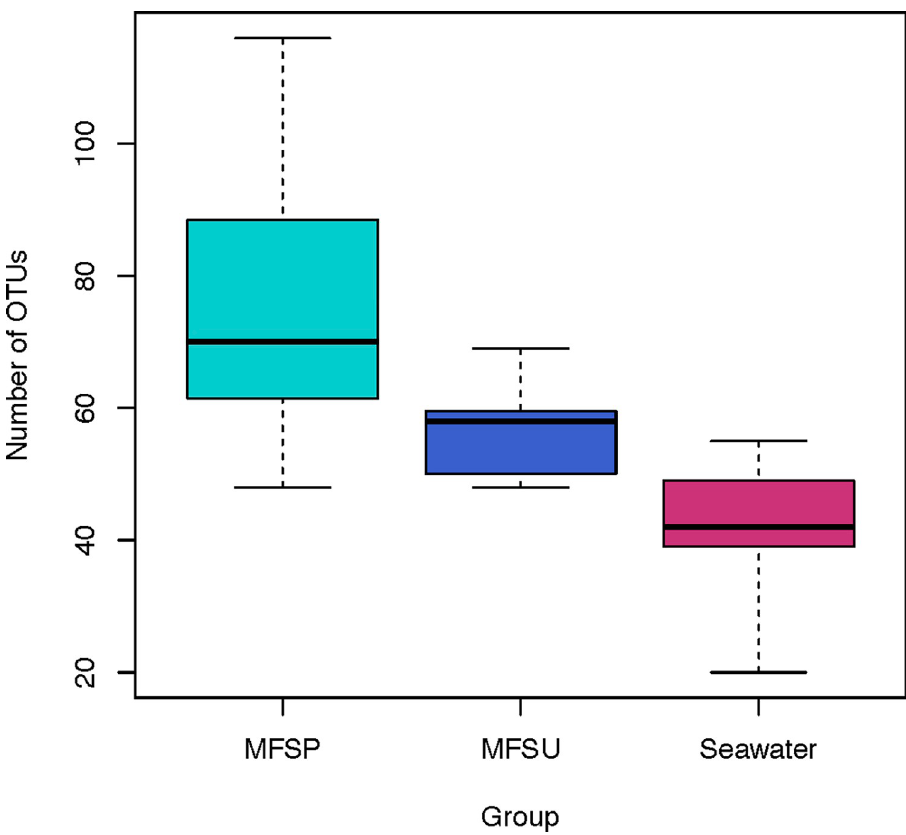
Fig 4. Number of observed OTUs per group of microfibers from spring (MFSP) and summer (MFSU) seasons, as well as from the Seawater, obtained from 16S amplicon sequence library, with significant difference between microfibers and seawater samples (Kruskal-Wallis, p <